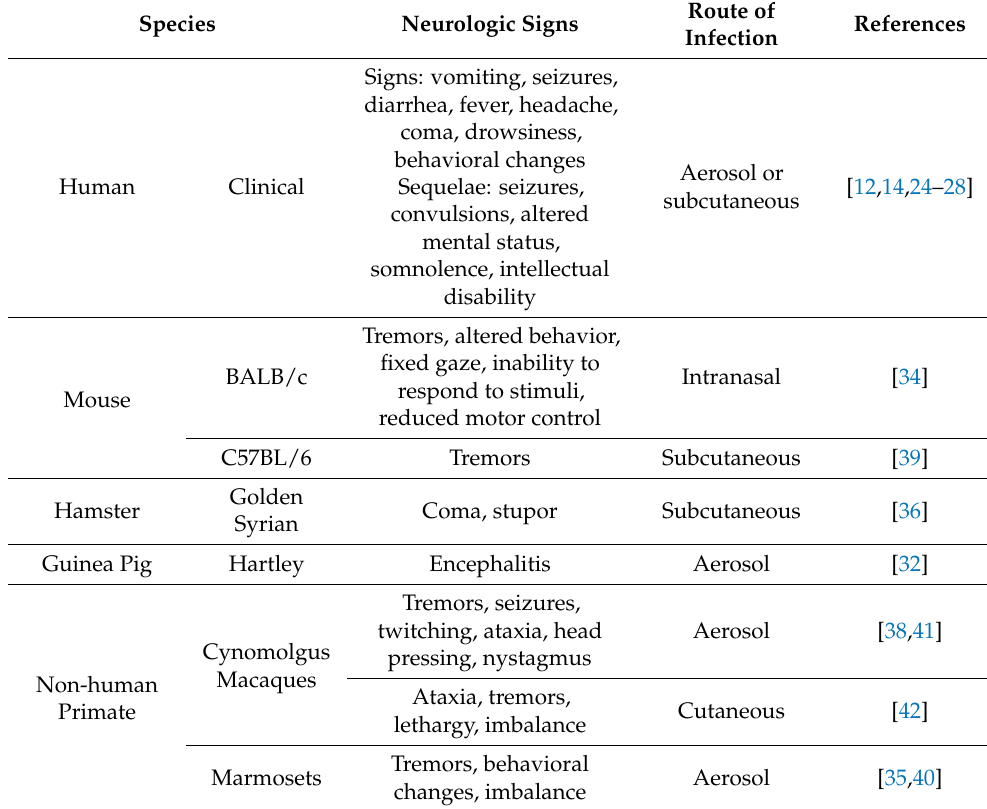
Table 1. Clinical and animal modeling of neurologic disease with eastern equine encephalitis virus (EEEV) infection. Species Neurologic Signs